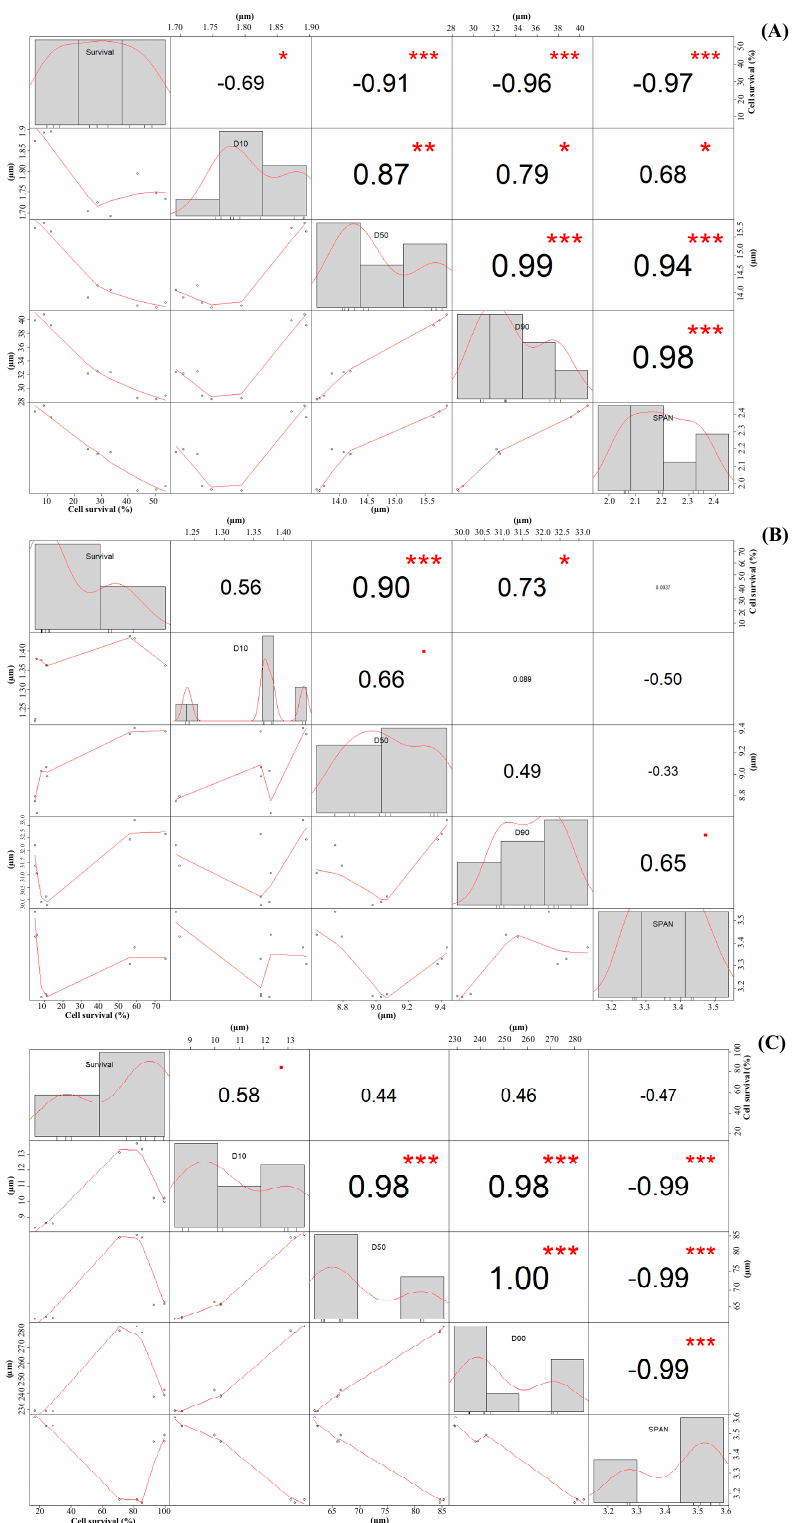
Figure 3. Pearson’s bivariate correlation analysis between particle size distribution values (D 10 , D 50 , D 90 , and span) and cell survival (%) for powders produced via CCSD ( A ), MXSD ( B ), and FD ( C ). Output numbers represent the correlation coe ffi cients. The starts represent the p -value of the correlations: * p < 0.05, ** p < 0.01, *** p <